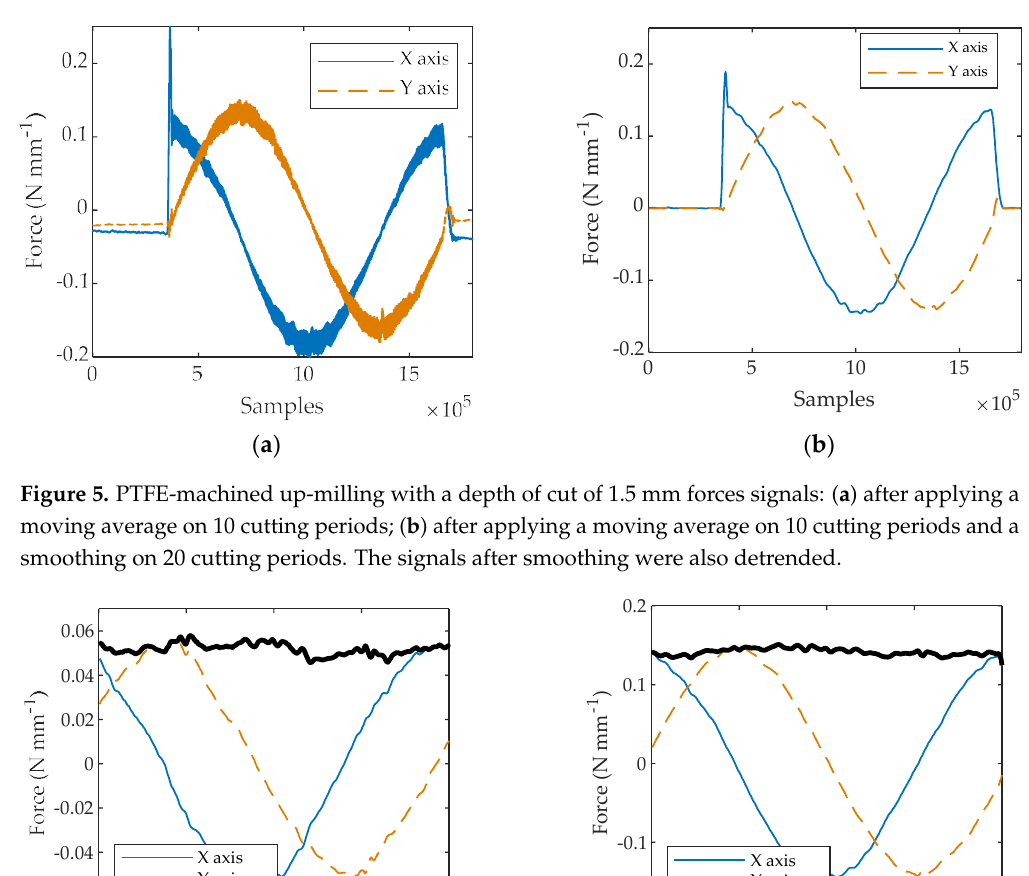
Figure 4. Rough cutting forces measured by the dynamometer X- and Y-axes when up-milling a PTFE disk with a depth of cut of 1.5 mm: ( a ) full signals; ( b ) same signals magnified over 10 tool revolutions. The forces are normalized by the sample thickness.